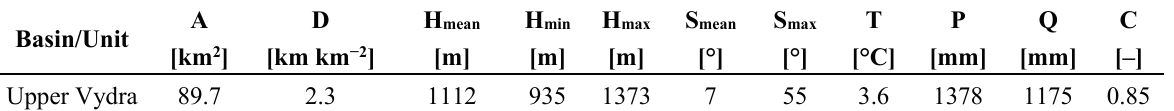
Figure 2. Key stages of the forest disturbance progress in the upper Vydra basin and the change in forest status between 1984 and 2011. Table 1. Physiographic characteristics of the upper Vydra